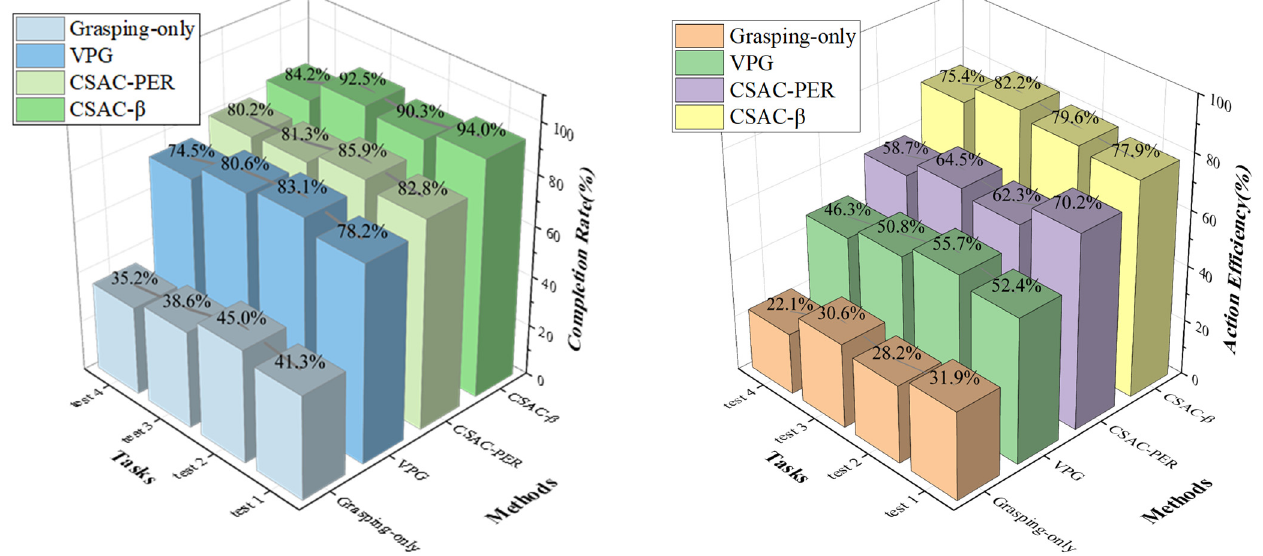
Figure 9. Evaluating the Performance of Grasping on Test Cases.